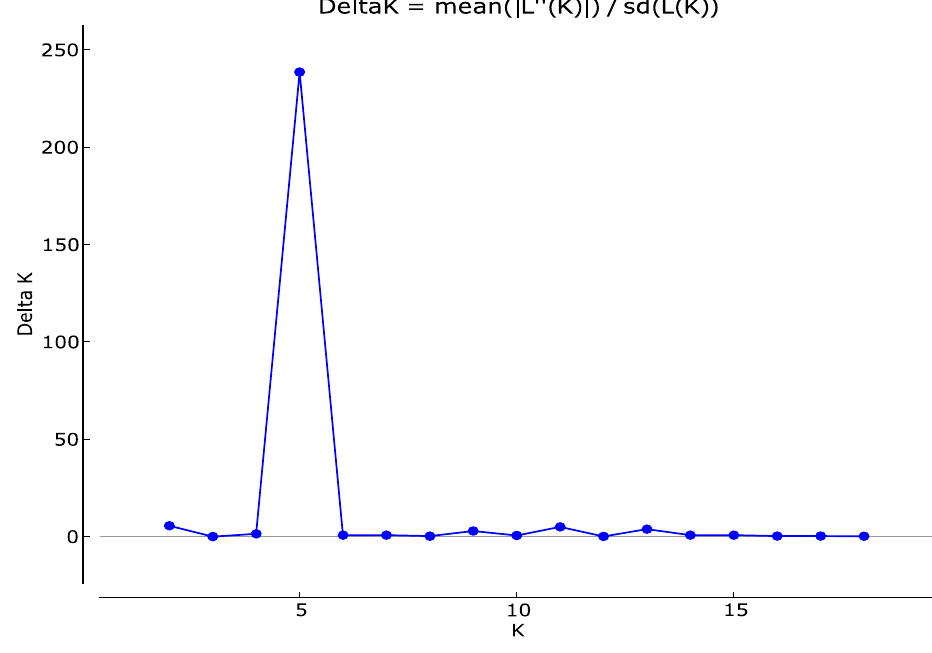
Figure 2. Graph representing the ∆ K values resulting from Structure Harvester software [47].